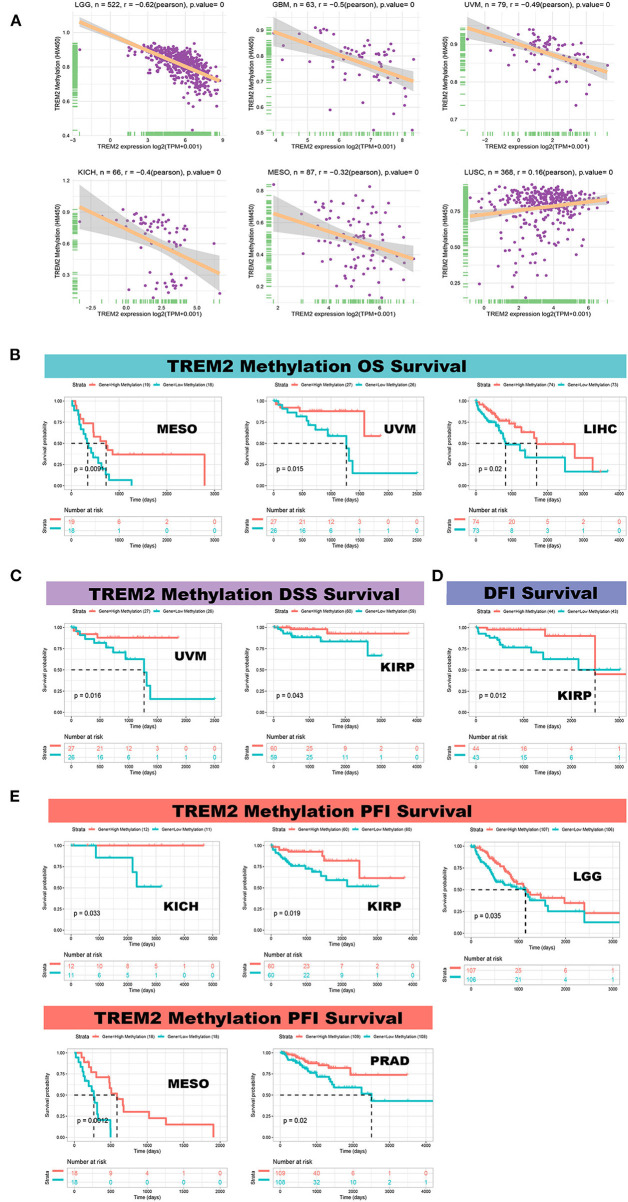
Correlation between TREM2 expression and gene promoter methylation. (A) Correlation between TREM2 expression and gene promoter methylation in brain lower grade glioma (LGG), glioblastoma multiforme (GBM), uveal melanoma (UVM), kidney chromophobe (KICH), mesothelioma (MESO), and lung squamous cell carcinoma (LUSC). (B) Correlation between TREM2 methylation overall survival in MESO, UVM, and liver hepatocellular carcinoma (LIHC). (C) Correlation between TREM2 methylation and disease-specific survival in UVM and kidney renal papillary cell carcinoma (KIRP). (D) Correlation between TREM2 methylation and disease-free interval in KIRP. (E) Correlation between TREM2 methylation and progression-free interval in KICH, kidney renal papillary cell carcinoma (KIPR), LGG, MESO, and prostate adenocarcinoma (PRAD).